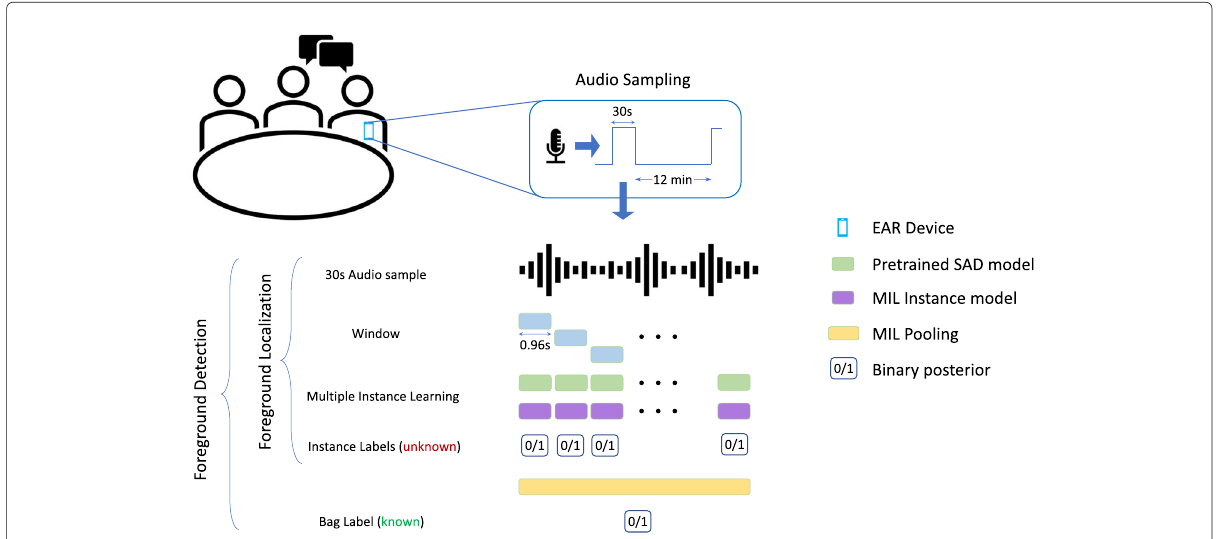
Fig. 1 MIL pipeline. Learning to detect and localize foreground speech in wearable-device